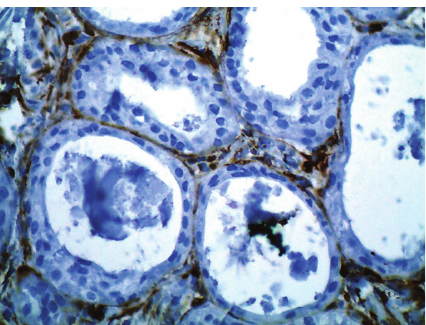
Figure 1: Large cystic spaces and cribriform structures were present throughout the lesion ( × 100).